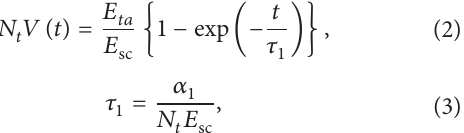
distribution bd bd